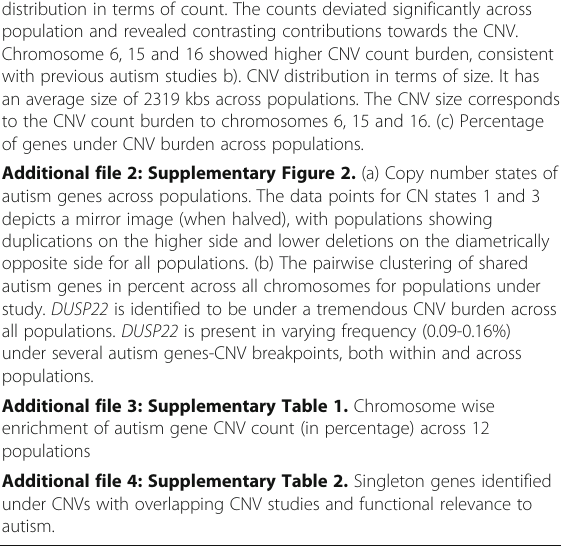
populations Additional file 4: Supplementary Table 2. Singleton genes identified under CNVs with overlapping CNV studies and functional relevance to